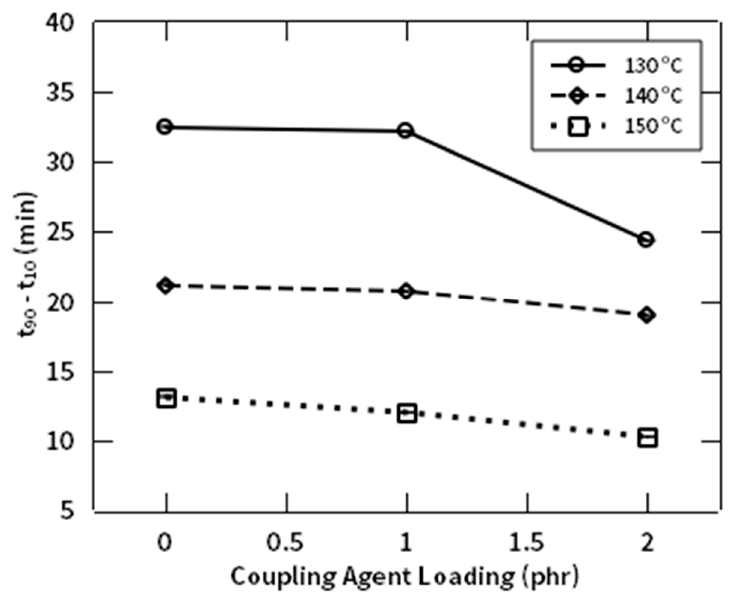
Figure 13. t 90– t 10 profile of NR compound at different composition of NR-g-St. Figure 13. t 90 –t 10 profile of NR compound at di ff erent composition of